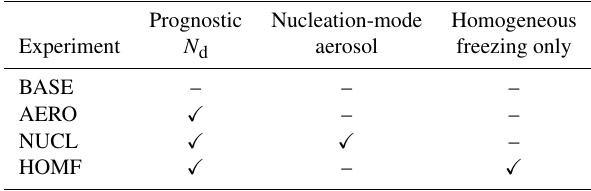
Table 1. Summary of NASA Unified Weather Research and Fore- casting (NU-WRF) simulations without and with aerosol input pro- file and prognostic droplet number concentration ( N d